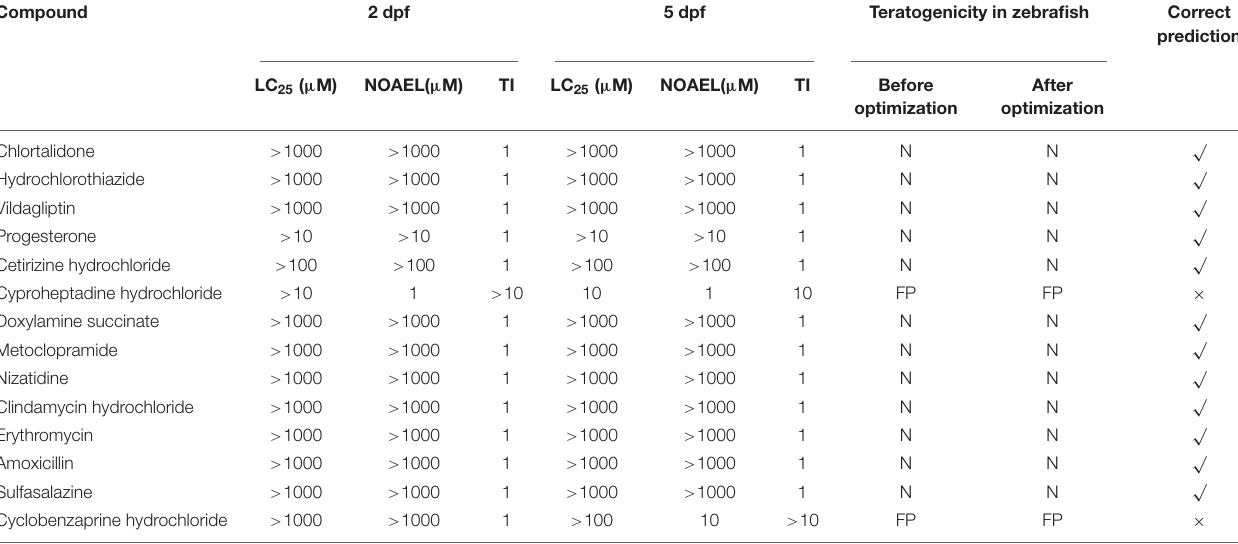
TABLE 4 | Developmental toxicity results of negative controls (non-teratogen) compounds in zebrafish. Compound 2 dpf 5 dpf Teratogenicity in zebrafish